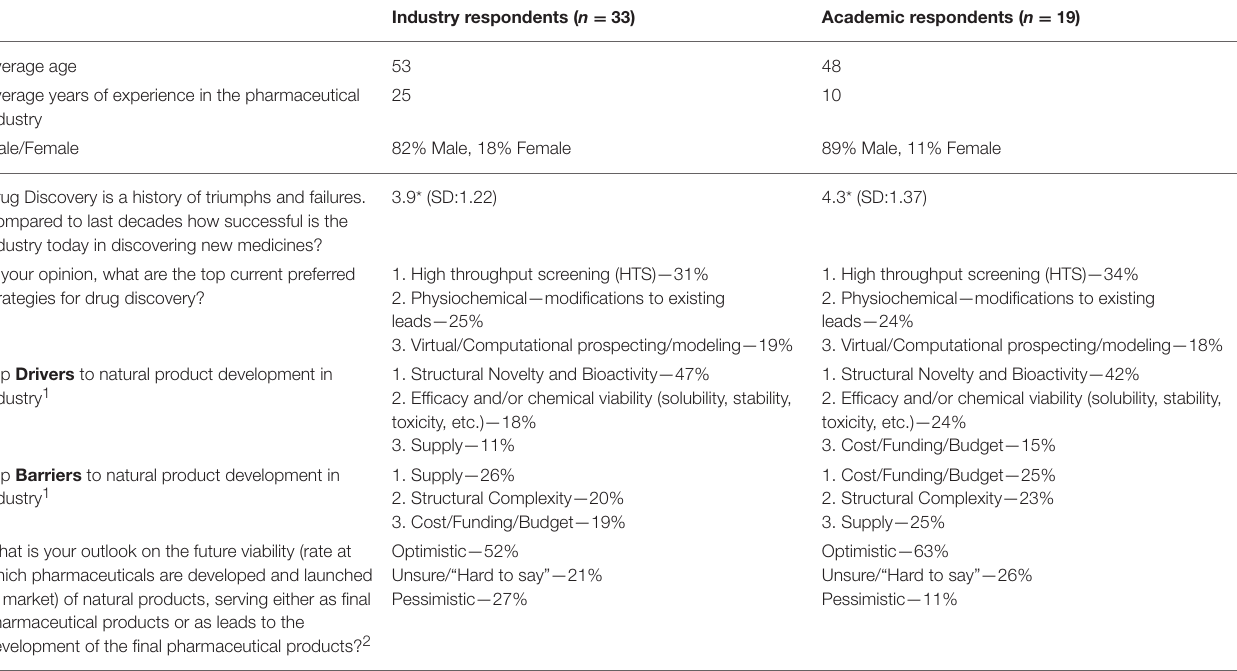
TABLE 2 | Results of the survey including selected close ended and profile